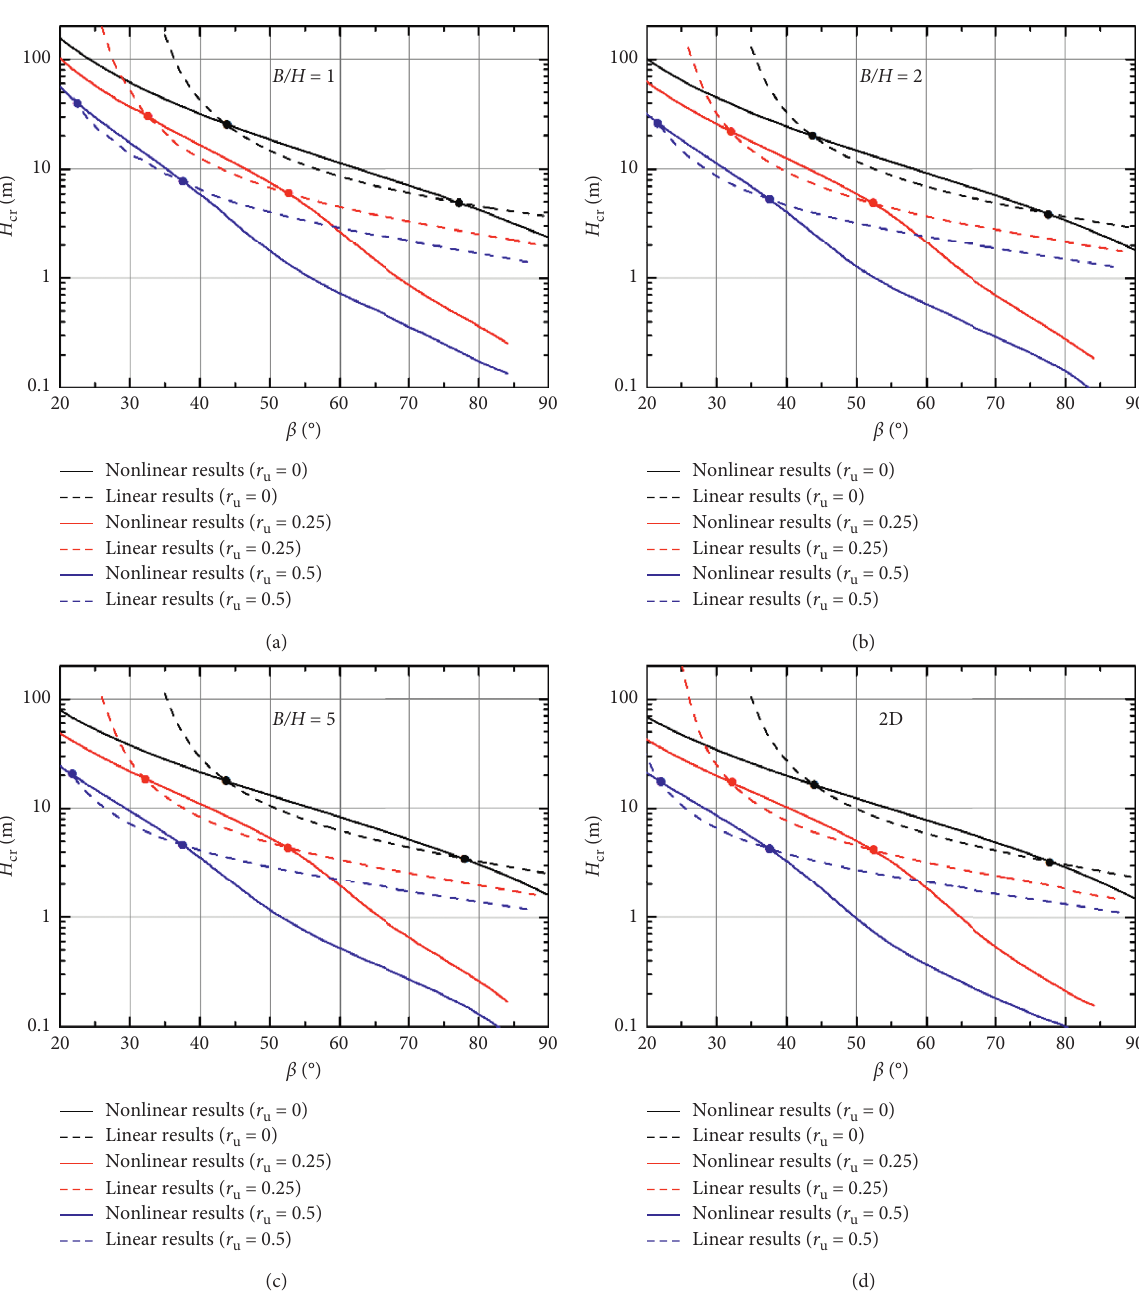
Figure 8: Critical heights of London clay slopes undergoing different pore-water pressures. (a) B/H � 1. (b) B/H � 2. (c) B/H � 5. (d)